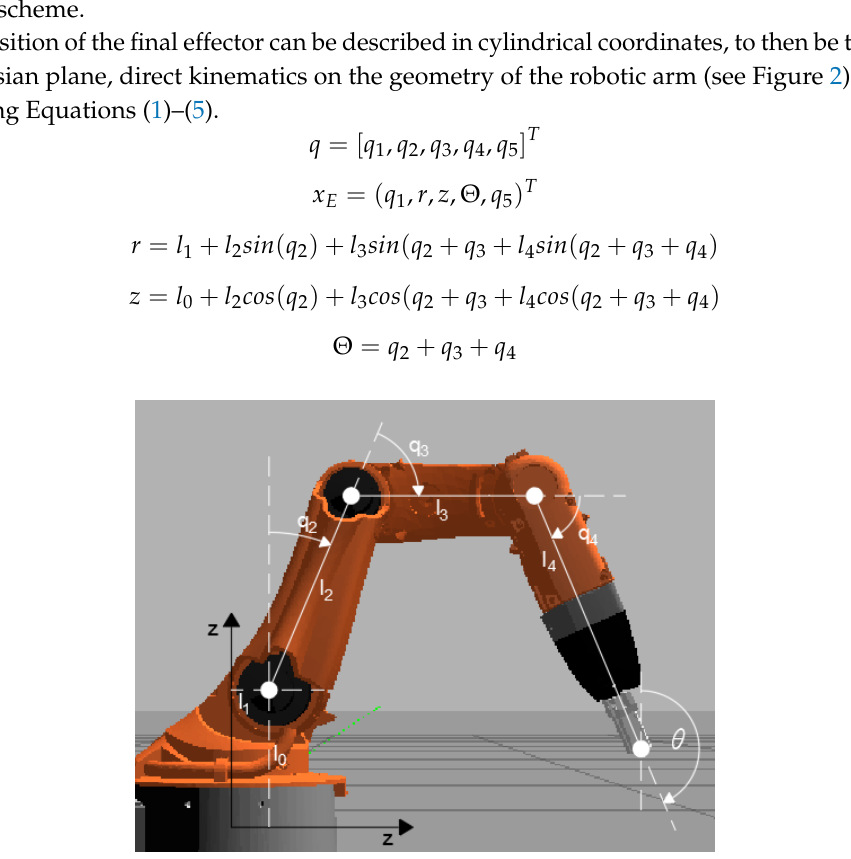
Figure 2. Geometry of the Kuka TM youBot Arm in the